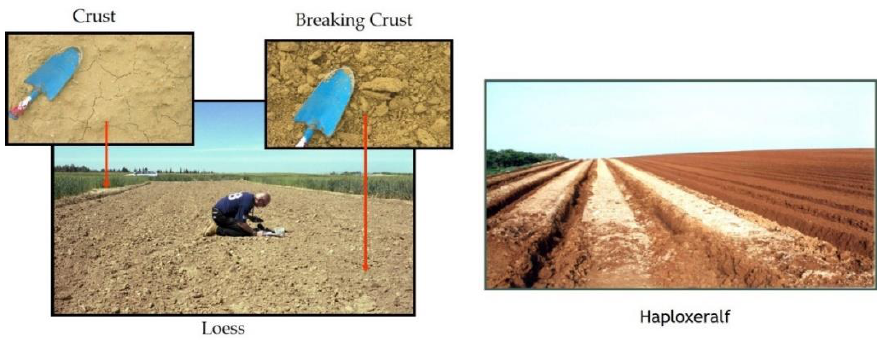
Figure 6. The undisturbed and disturbed soil surfaces at Afeka site, Israel [82] .